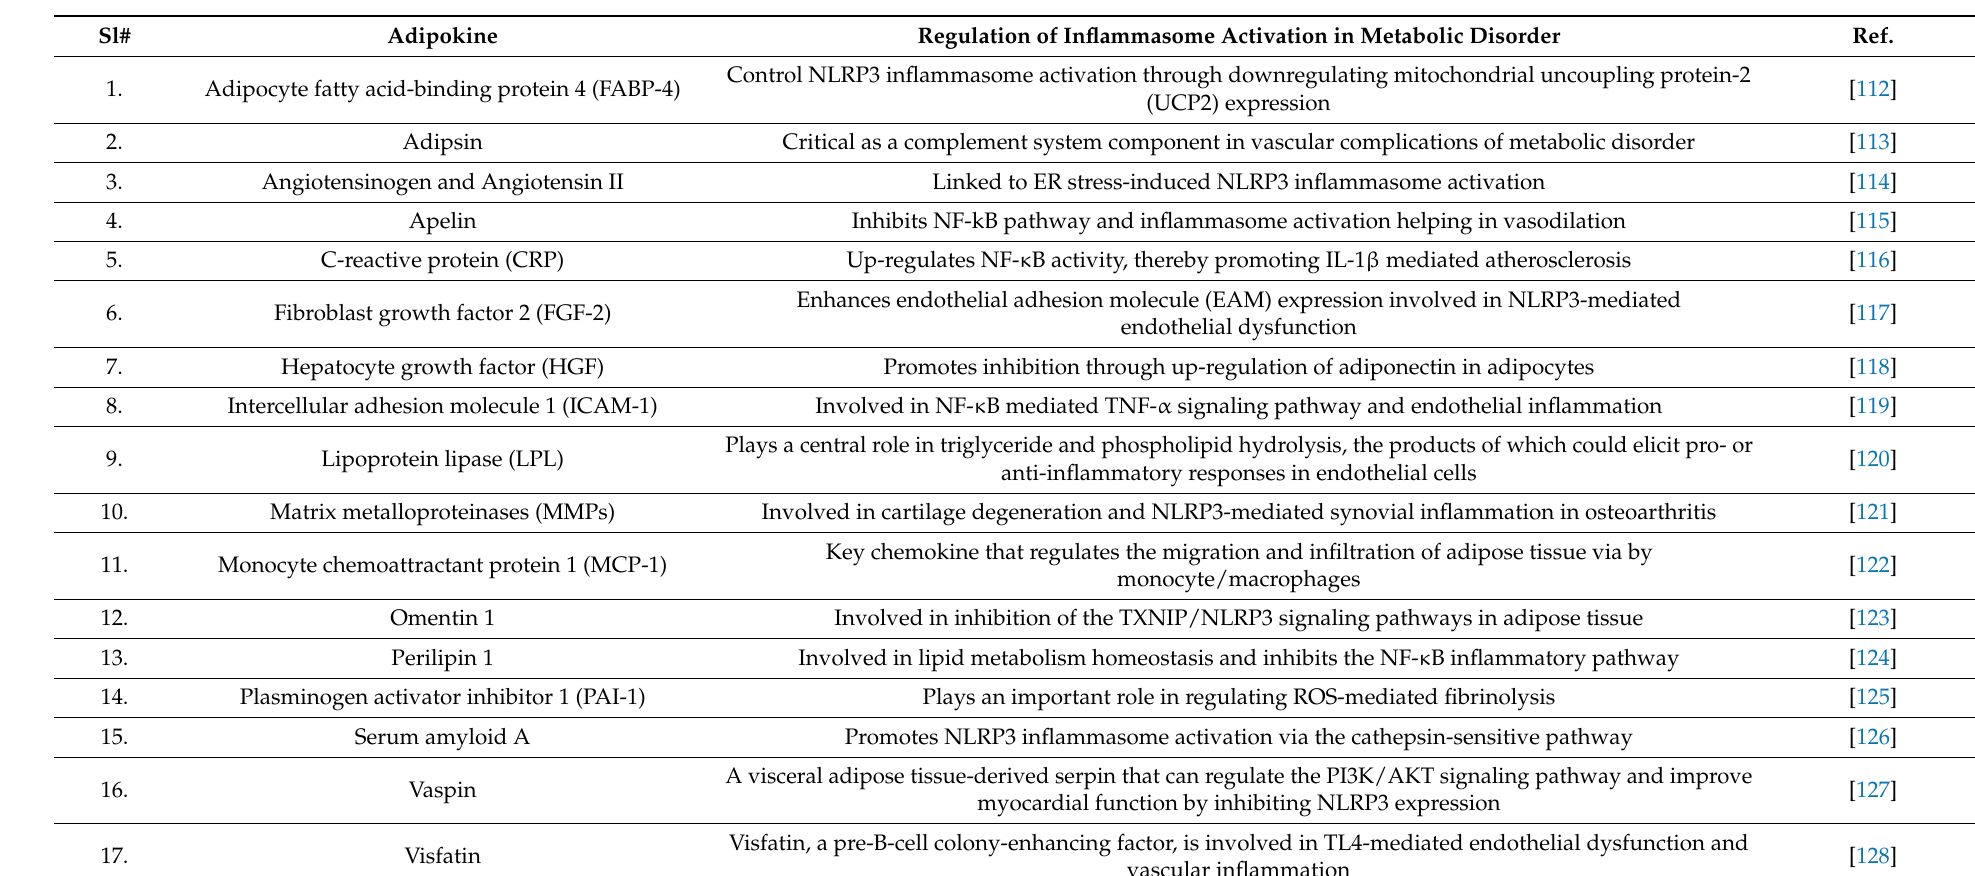
Table 2. Role of adipokines in the regulation of NLRP3 inflammasome